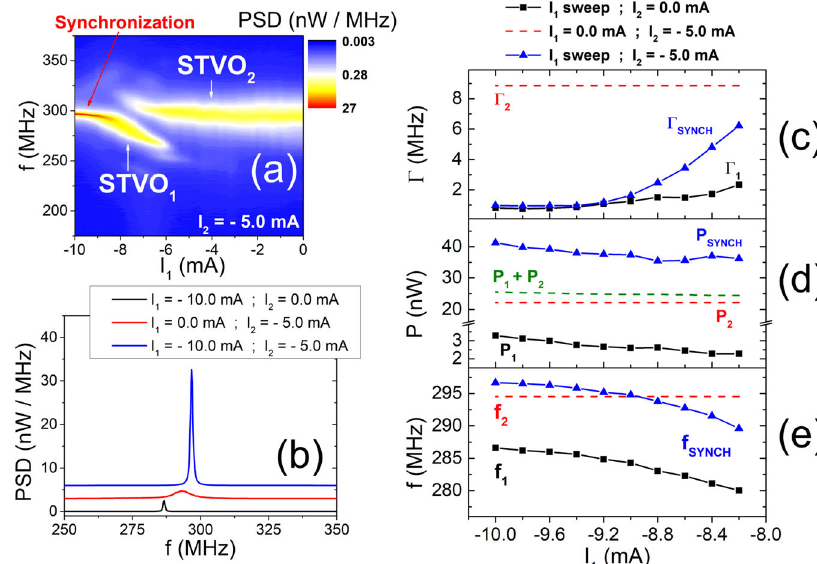
Fig. 3 Synchronization of two dipolar-coupled oscillators. a Power spectral density (PSD) measured for two spin torque vortex oscillators (STVO 1 and STVO 2 ) with an edge-to-edge distance of 100 nm, as a function of the direct current I 1 passing through STVO 1 . The direct current I 2 applied to STVO 2 is − 5.0 mA. b Example of the PSD obtained for I = − 10.0 mA and I = − 5.0 mA for single (black and red) and combined (blue) oscillations. c Linewidth, 1 2 d output power and e frequency calculated as a function of I 1 for I 2 = 0.0 mA (black) and I 2 = − 5.0 mA (blue). For an easy comparison, the parameters obtained for an isolated oscillation of STVO 2 at I 2 = − 5.0 mA (red) are also shown without any connection with the I 1 axis. A perpendicular magnetic fi eld of 2.8 kOe was applied during the Fig. 3c, at I 1 = − 10.0 mA]. The increase of the I 1 magnitude is also followed by an increase of the synchronized state frequency [f SYNCH in Fig. 3e]. For I 1 ≤ − 9.0 mA, f SYNCH goes above both f 1 and f 2 single-running frequencies of STVO 1 and STVO 2 , respectively, which is a behaviour already veri fi ed in the literature for synchronized STVOs 8 . These results already demonstrate the fi ngerprint of a synchronization of the two STVOs 7,9 , but they still lack the demonstration that the two oscillators are locked with a constant phase difference between them.